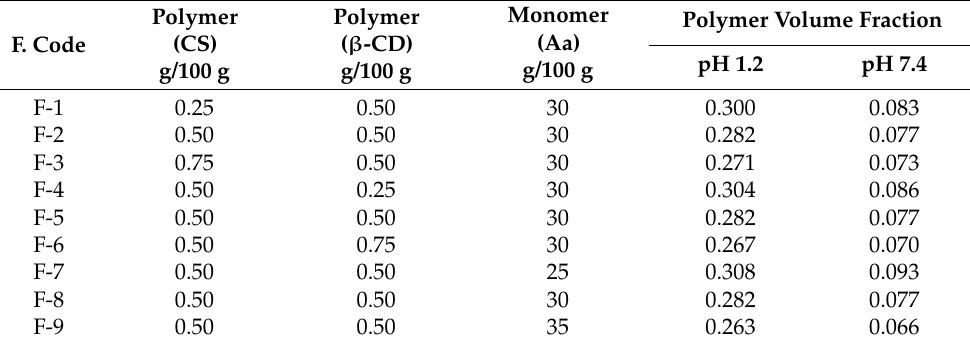
Table 1. Feed ratio scheme for the formulation of CS/ β -CDcPAa hydrogels. F.